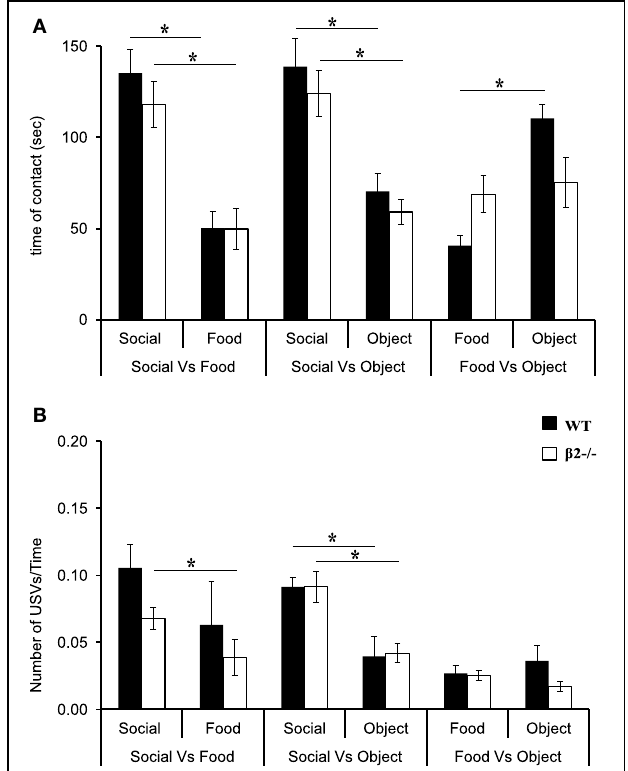
FIGURE 2 | Reward ranking of β 2 − / − and WT mice in safe environment. (A) Time spent in contact with each reward. (B) Number of ultrasonic vocalizations— USVs—emitted in contact with each reward divided per the time spent in the room. Data are presented for WT and β 2 − / − mice as mean ± SE. ∗ p < 0 . 005; for Mann-Whitney paired